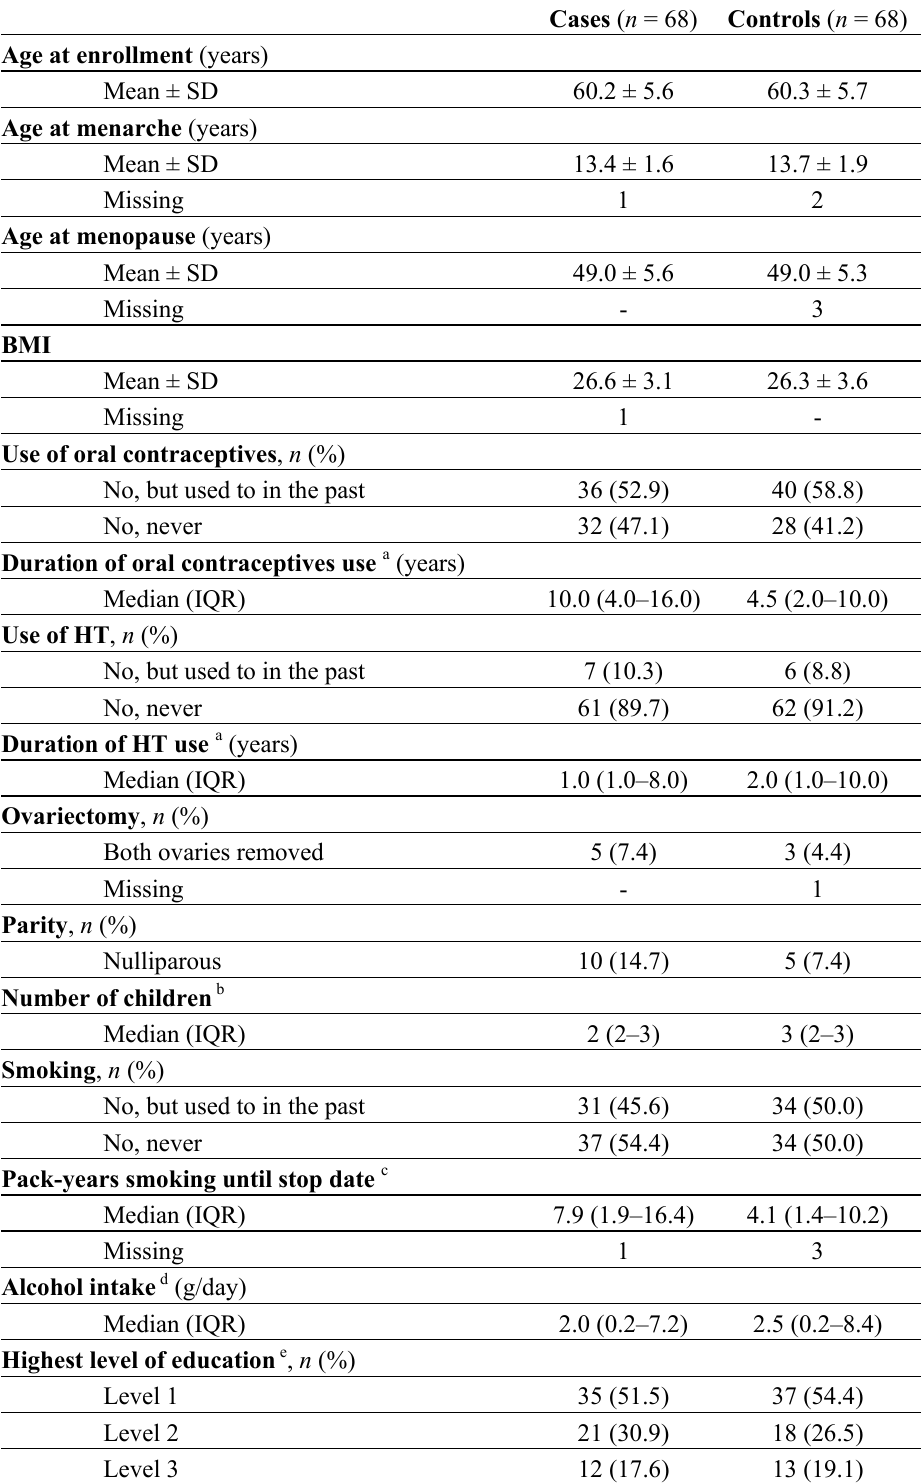
Table 2. Study population